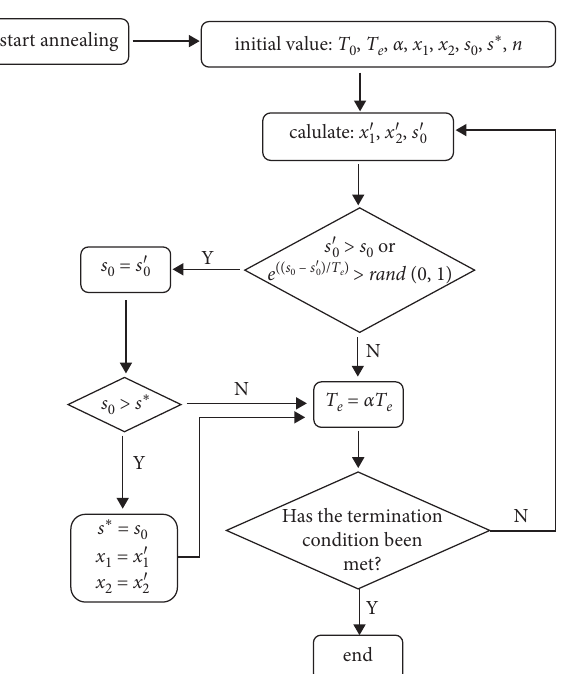
Figure 4: The signal timing optimization flow chart with simulated annealing